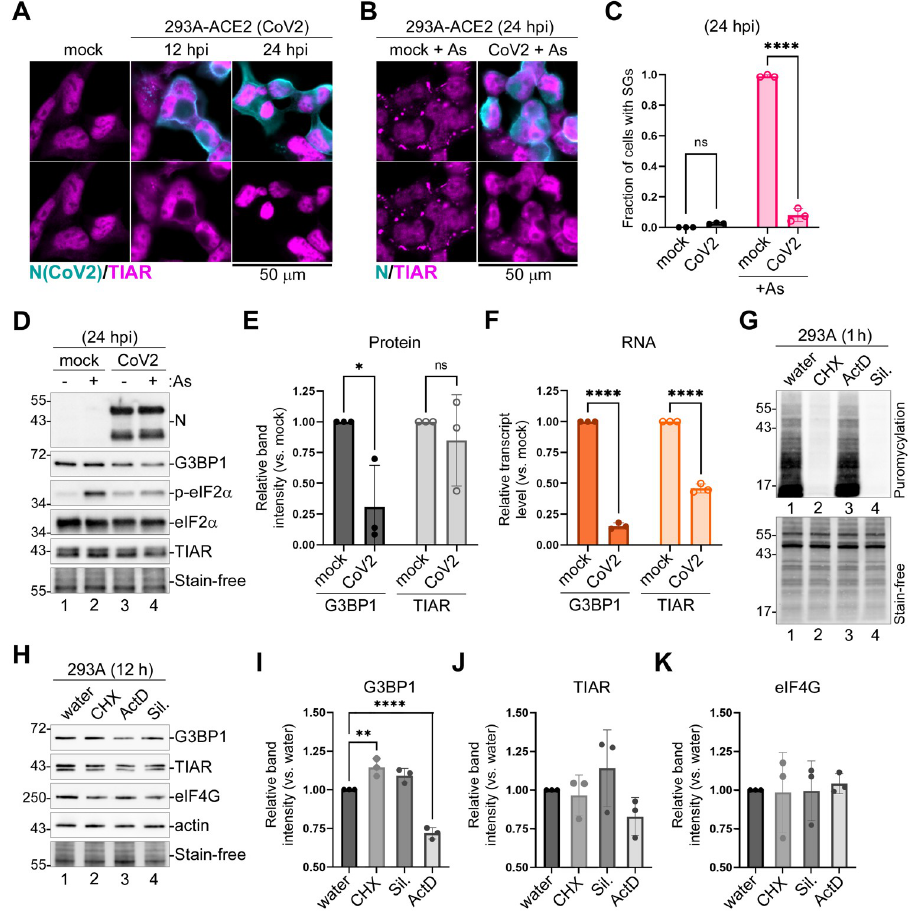
Fig 3. SARS-CoV-2 inhibits SG formation and decreases expression of G3BP1. (A) 293A-ACE2 cells were infected with CoV2 at MOI = 1.0 and mock and CoV2 infected cells were analysed by immunofluorescence microscopy using immunostaining for viral nucleoprotein (N, teal) and SG marker TIAR (magenta) at the indicated times post-infection. (B) Immunofluorescence microscopy of mock and CoV2 infected 293A-ACE2 cells treated with As at 24 hpi. Staining was performed as in (A). In (A) and (B) scale bars = 50 μ m. (C) Fraction of cells with SGs was quantified in mock and CoV2 infected cells treated and stained as in panel (B). Error bars = standard deviation. Two-way ANOVA and Tukey multiple comparisons tests were done to determine statistical significance ( ���� , p -value < 0.0001, ns = non- significant). (D) Western blot analysis of As-induced eIF2 α phosphorylation and accumulation of N protein in 293A-ACE2 cells at 24 hpi. Levels of SG nucleating proteins G3BP1 and TIAR were also analyzed, fluorescent total protein stain (Stain-free) was used as loading control. (E) Band intensity of G3BP1 and TIAR normalized to total protein (Stain-free) quantified from 3 independent experiments represented in D (lanes 1 and 3), ( � , p -value < 0.05, ns, non-significant, as determined by unpaired Students t-Test). (F) Relative transcript levels of G3BP1 and TIAR determined by RT-QPCR ( ���� , p -value < 0.0001, ns, non-significant, as determined by unpaired Students t-Test). (G) Ribopuromycylation assay in 293A cells treated with cycloheximide (CHX), Actinomycin D (ActD), Silvestrol (Sil.) or water control. Top—puromycin incorporation detected by western blot. Bottom–total protein visualized by Stain-free dye. (H) Western blot of 293A cells treated as in G for 12h. (I-K) Relative band intensity of G3BP1 (I), TIAR (J), and eIF4G (K) normalized to total protein (Stain-free), quantified from 3 independent experiments represented in H. Two-way ANOVA and Tukey multiple comparisons tests were done to determine statistical significance ( �� , p -value < 0.01; ���� , p -value < 0.0001). On all plots each data point represents independent biological replicate (N = 3). Error bars = standard